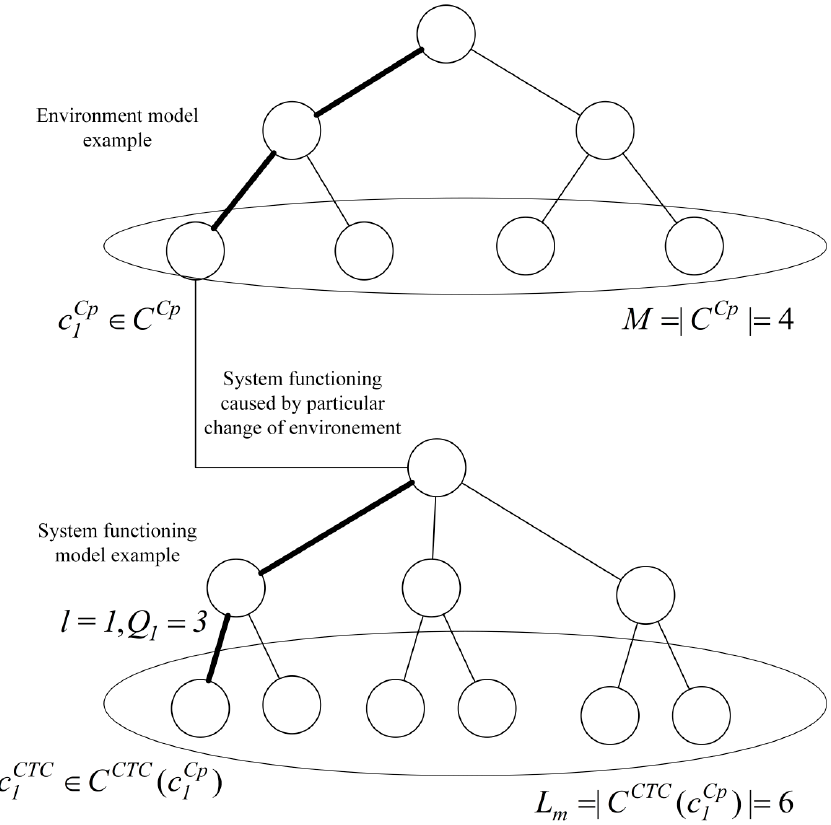
Figure 6. Example of environment and system functioning models elements relations.